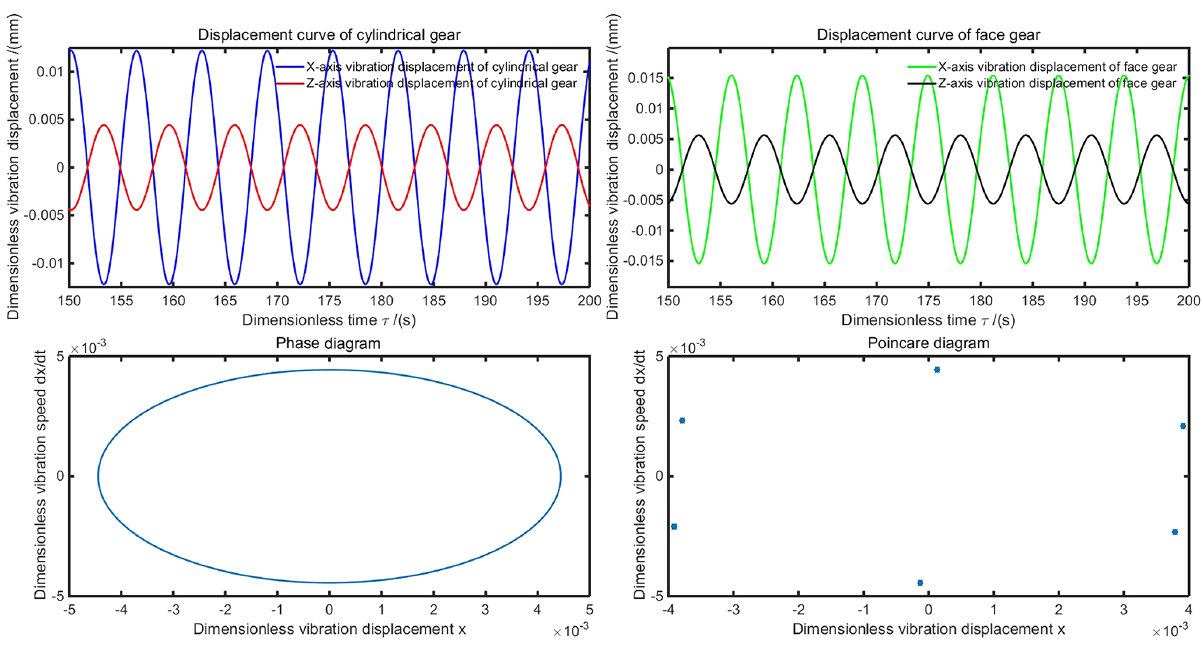
Figure 6. Displacement, phase, and Poincare diagrams of 3rd stage face gear